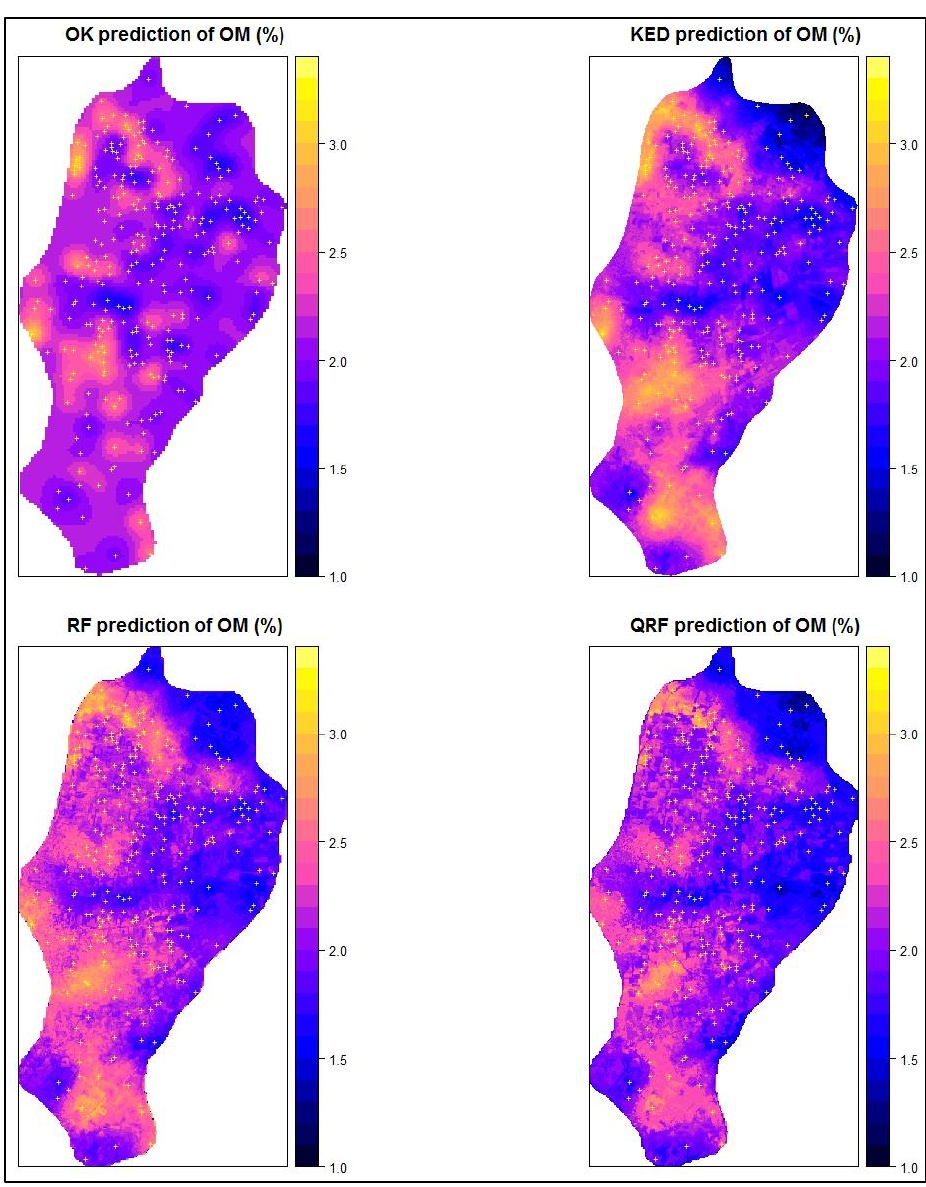
Figure 10. Prediction maps of soil OM.